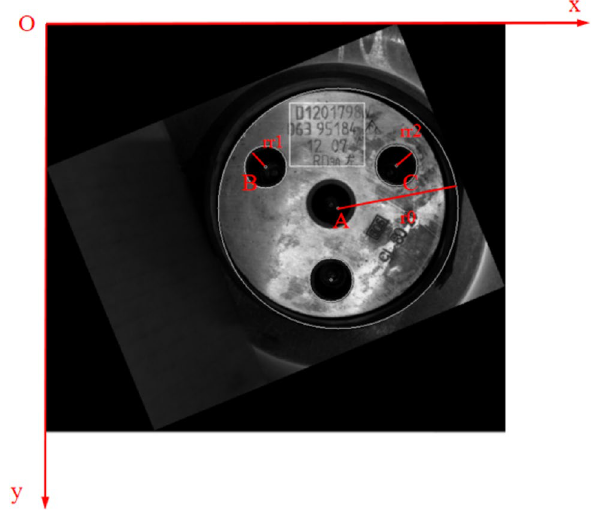
Fig. 16 Division principle coordinate of the large circle, and rr1 and rr2 represent the radius of the small circle.